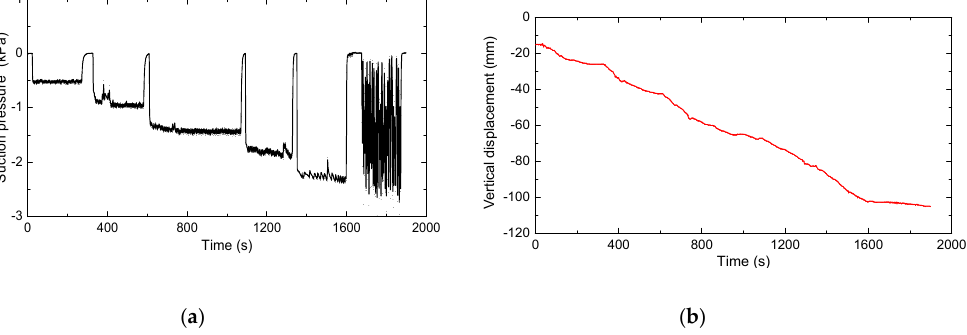
Figure 7. Variations in suction and displacement with time in PS1-2. ( a ) Relationship between suction and time; ( b ) Relationship between displacement and time.